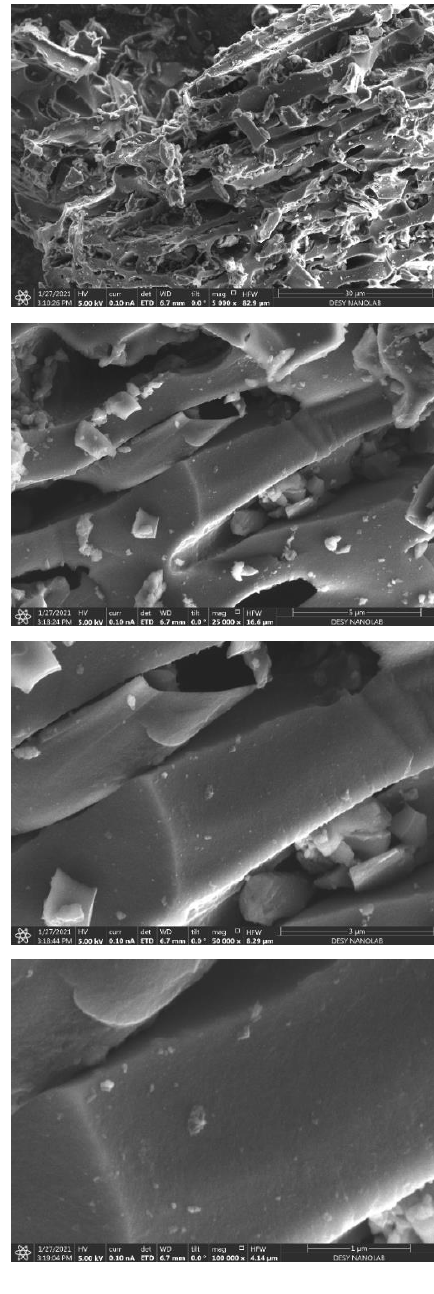
Figure 2. HR-SEM images of the microporous carbons: left set of images − 1.18 mm granulation, right set of images − 90 μ m.